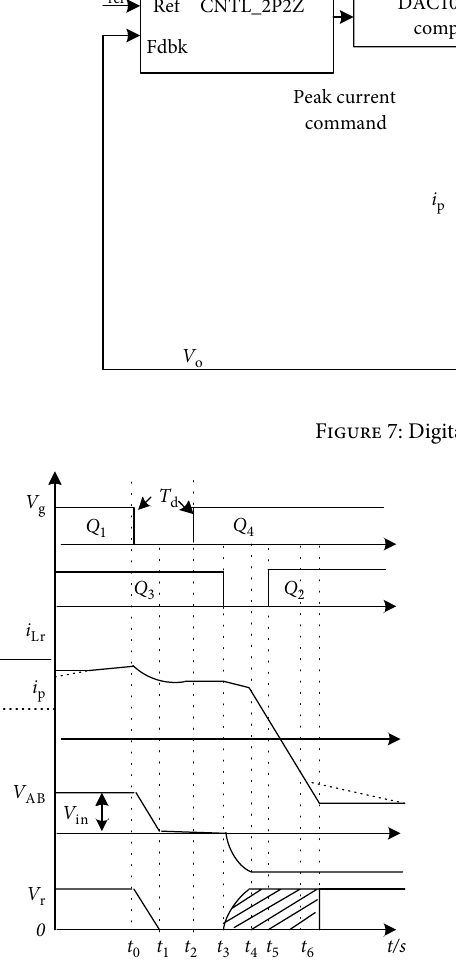
Figure 8: Operating waveforms of DC/DC converter.